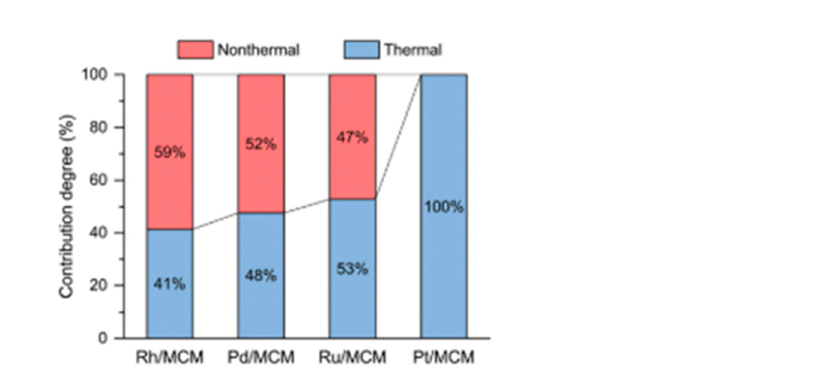
Figure 53. Contribution of thermal and nonthermal effects over various metal-loaded MCM-41’s. Reproduced from [71] with permission from The Royal Society of Chemistry.